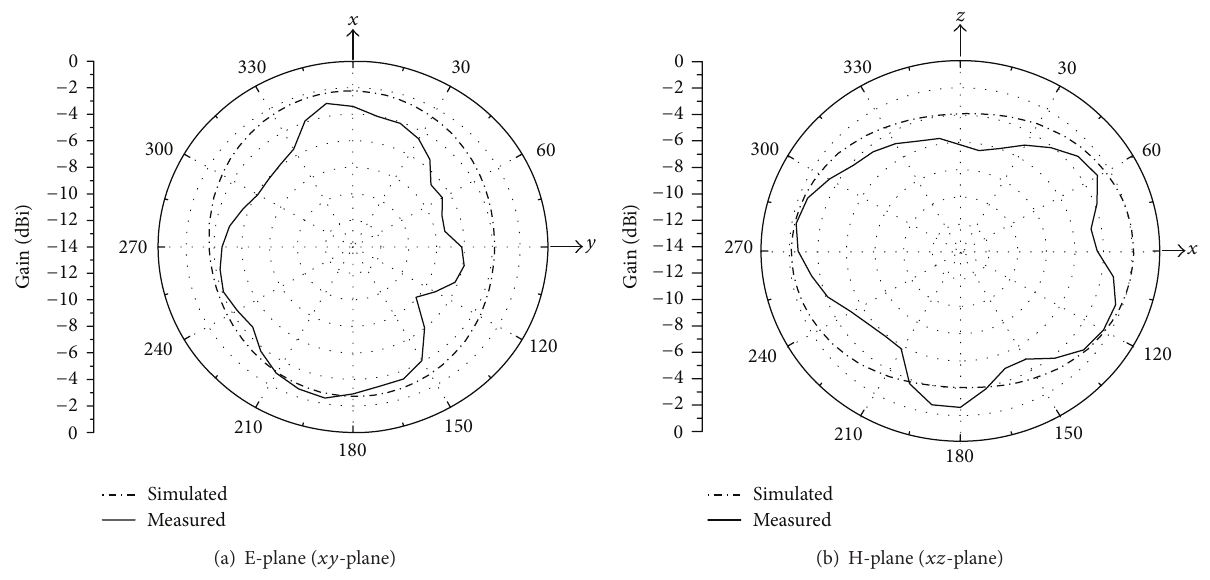
Figure 8: Simulated and measured far-field radiation